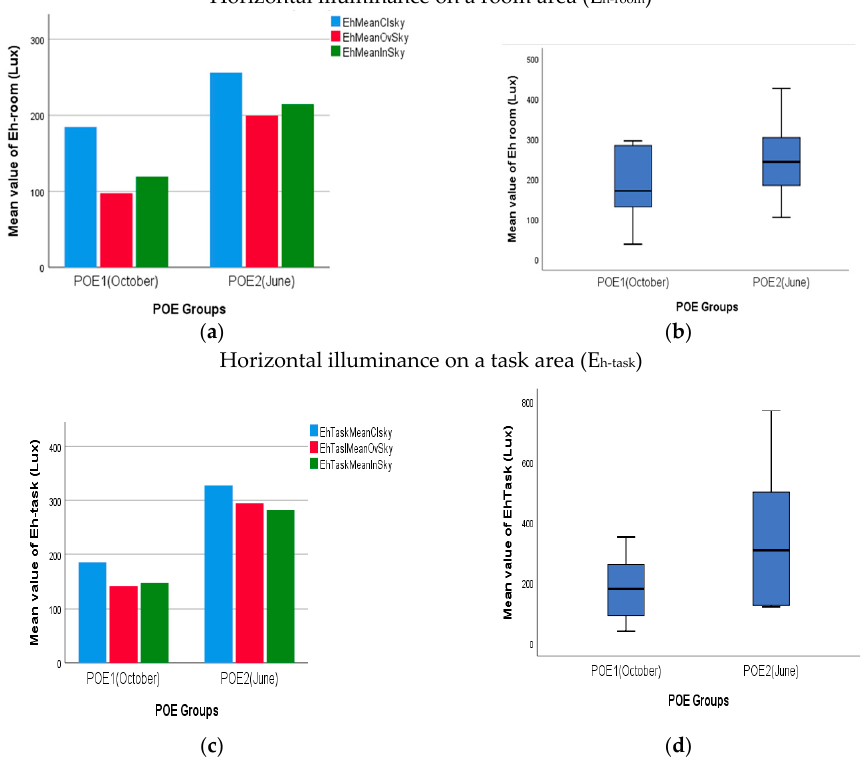
2. Horizontal illuminance on a task area (E h-task )—Based on the position of the desk area in each room, the mean horizontal illuminance received on task area E h-task was calculated. As presented in Figure 4c,d, on average, the amount of daylight received at the task area in June was approximately 100 lux higher compared to October. Under the clear sly condition, the areas received, on average, 300 lux with a variation between 100 and 800 lux (see Figure 4d). 3. Vertical eye illuminance (E v-eye )—Vertical eye illuminance E v-eye was calculated at the center point of each room with a viewing direction towards the daylight opening. The results of E v-eye under three different sky conditions are illustrated in Figure 4e. 4. Daylight Autonomy (DA) and Spatial Daylight Autonomy (sDA)—The highest value for DA was found for the rooms on the second floor, with an average of 44 ± 8%. The rooms on the third floor at the north-east side had DA values around 29 ± 3%, and the south-west side had the lowest DA values around 2 ± 0.3%. sDA values of all rooms were lower than 50% of the space area. 5. Daylight Glare Probability (DGP)—The center point of each room with a direction towards windows was elected for DGP analysis. The results of this analysis show that, under the ‘clear’ sky condition, DGP values were in the range of intolerable glare (DGP > 0.45) for 70% of the rooms in October and for all the rooms in June. Under ‘overcast’ and ‘intermediate’ sky conditions, DGP values were below the ‘imperceptible’ level (DGP < 0.35) in October and at the ‘perceptible’ level (0.40 < DGP < 0.35) in June. The mean DGP values for the rooms under the three sky conditions are presented in Figure 5. The variations in DGP values under the clear sky condition are presented in the right image. 6. Annual Sunlight Exposure (ASE)—For all rooms, less than 10% of the areas had an illuminance value higher than 1000 lux/250 h per year, which means that, according to the LEED certification, the rooms are categorized as ‘a room with not too much direct sunlight during the year’ [23].